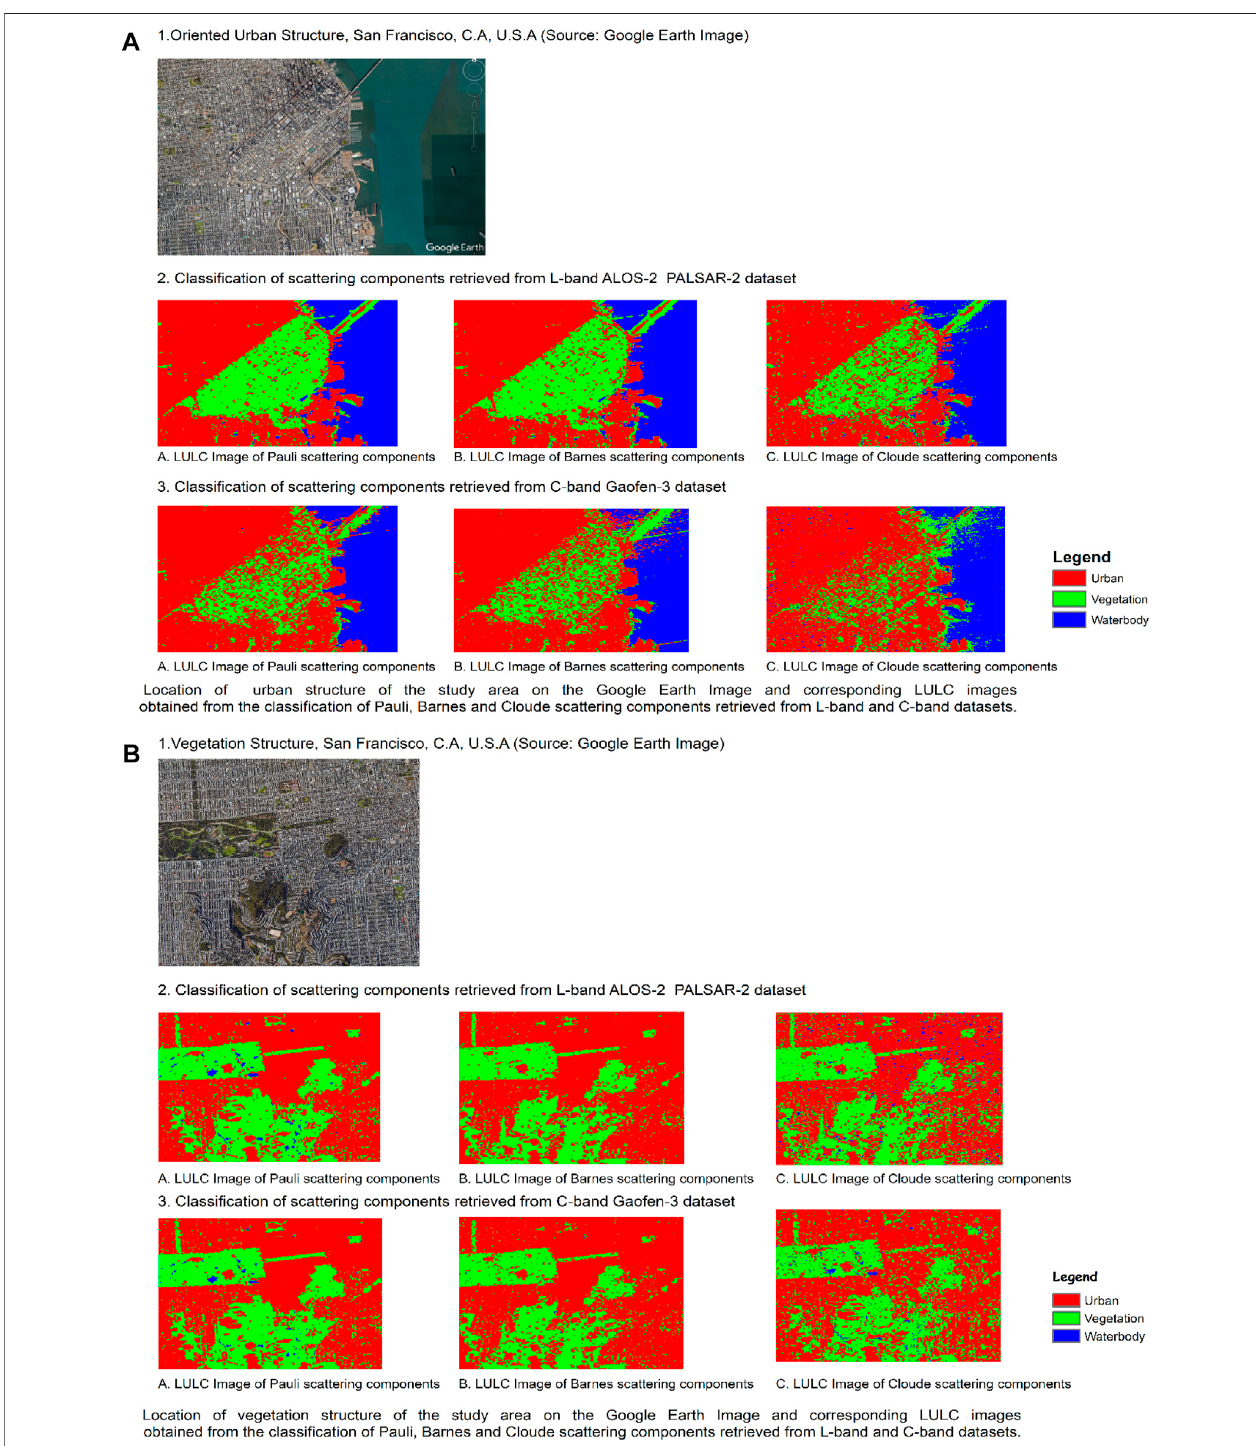
FIGURE 12 | Location of vegetation structure and urban structure of study area on Google Earth Image and corresponding LULC images obtained from classi fi cation of Pauli, Barnes, and Cloude scattering components retrieved from L-band and C-band datasets.